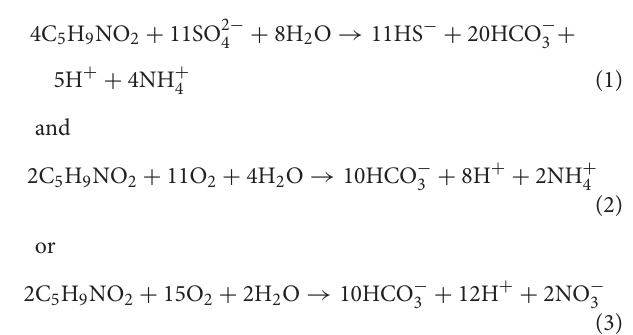
Frontiers in Microbiology |